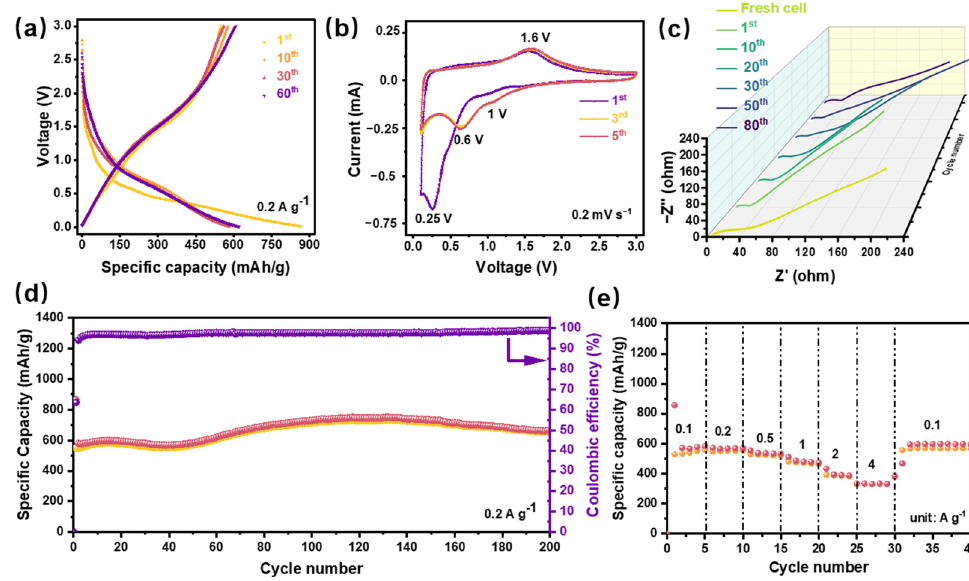
Figure 4. Electrochemistry characterization of the 6-SHEO. ( a ) Voltage vs. capacity profile testing at 0.2 A g − 1 , ( b ) cyclic voltammetry at a scanning rate of 0.2 mV s − 1 , ( c ) comparison of electrochemical impedance spectroscopy (EIS) of different cycles at fully charged state, ( d ) capacity retention at 0.2 A g − 1 , ( e ) rate-performance measured at various current densities.